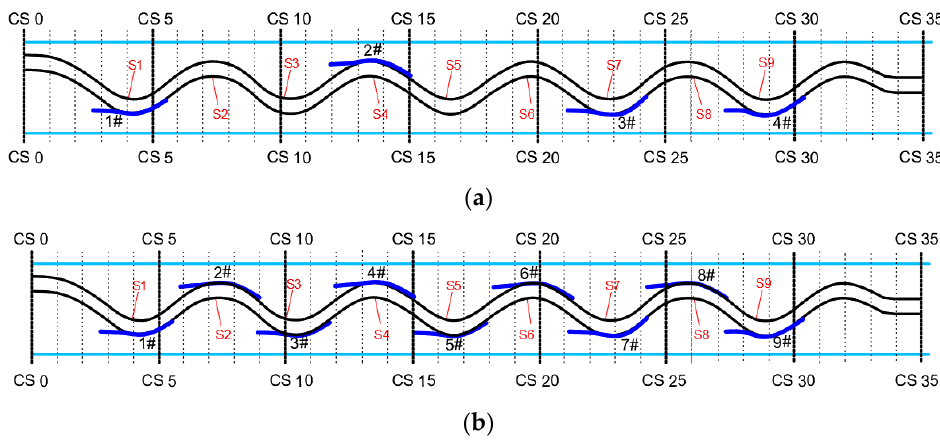
Figure 3. Scheme of the model test layout: S1 to S9 represent river bends. ( a ) Four regulation works: 1#~4#, respectively, refer to Project 1, Project 2, Project 3 and Project 4. ( b ) Nine regulation works: 1#~9#, respectively, refer to Project 1, Project 2, Project 3, Project 4, Project 5, Project 6, Project 7, Project 8 and Project 9.